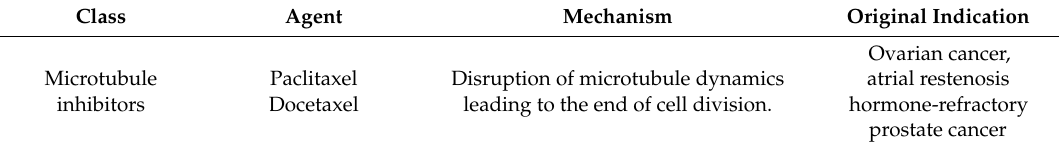
Table 1. Summarized approved agents for non-metastatic triple-negative breast cancer